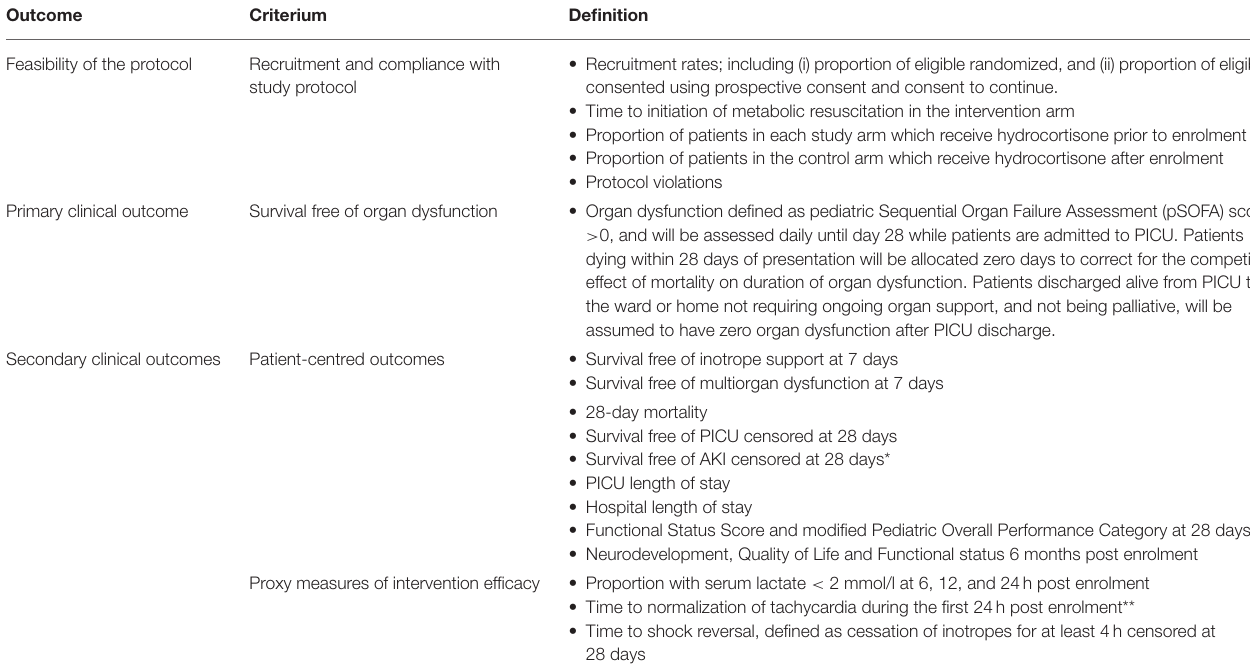
TABLE 2 | Outcomes assessed.